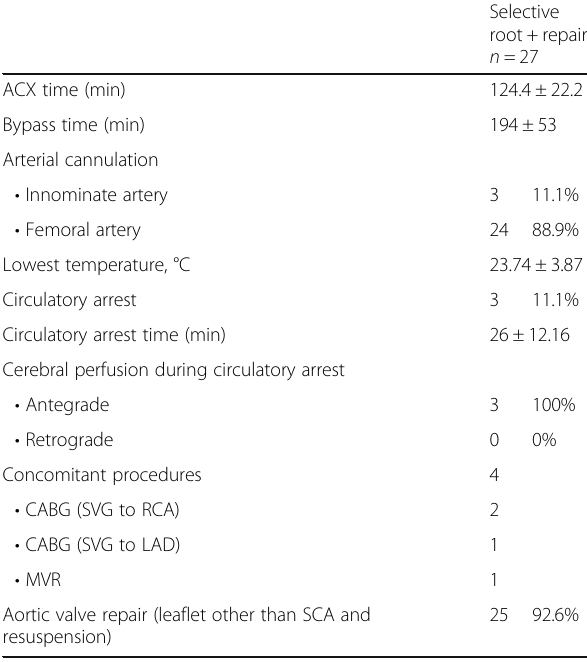
Table 3 Operative details